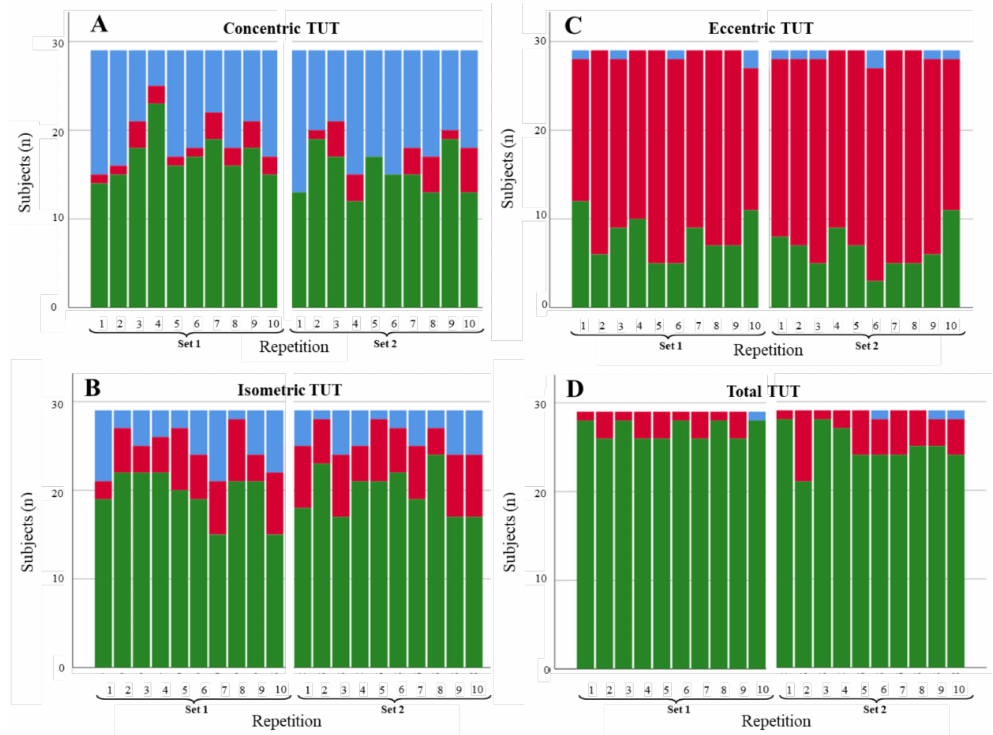
Figure 6. Degree of compliance of TUTs for the fast extension scenario by contraction phase: ( A ) concentric, ( B ) isometric, ( C ) eccentric, and ( D ) total. TUTs: in range = green; performed in less time than expected = blue; performed in more time than expected = red.